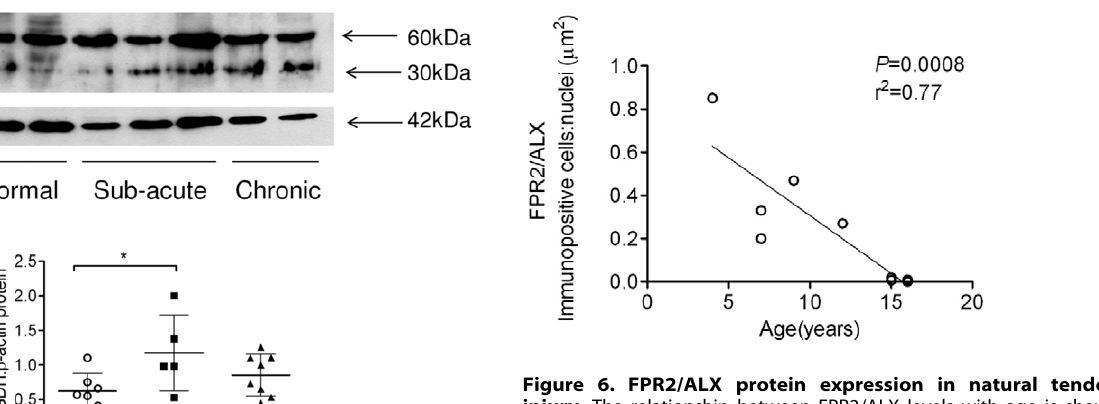
Figure 6. FPR2/ALX protein expression in natural tendon injury. The relationship between FPR2/ALX levels with age is shown in injured flexor tendons (n=10). Horse age ranged between 4 and 16 years (mean 11 6 4 years). FPR2/ALX expression was significantly reduced with increasing age ( P =0.0008, r 2 =0.77). Overlapping points are present for tendons derived from more than one 15 and 16 year old